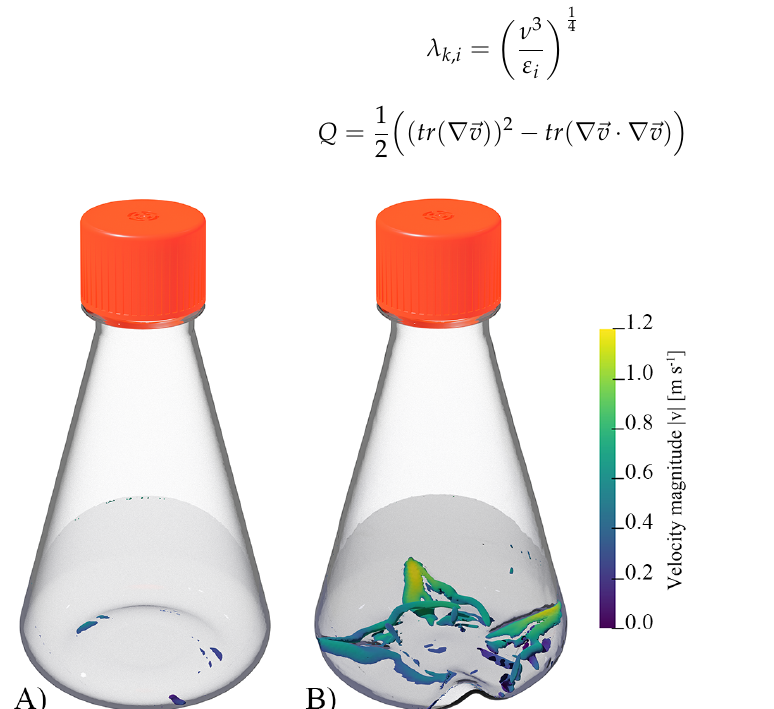
Figure 4. CGI of the CFD simulations for the two shake flask configurations. ( A ) represents the 500mL shake flask without baffles and ( B ) represents the shake flask with baffles. Shaded in grey is the liquid surface at 130rpm and 160mL working volume. Furthermore, the iso-contours at Q = 1000s − 2 are shown and coloured with the fluid velocity. The iso-contours visualise regions with vortex